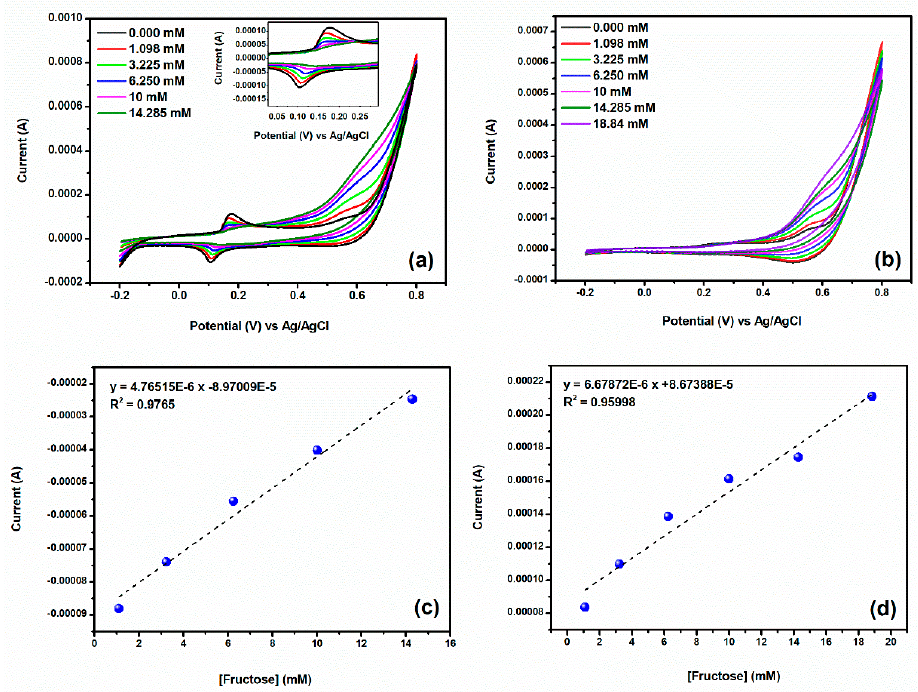
Figure 10. Effect of fructose concentration in 0.1 M NaOH solution at a scan rate of 25 mV s − 1 using ( a ) HPC-Co (1) modified electrode and ( b ) HPC-CoO (2) modified electrode. Calibration curves obtained ( c ) from the redox peak (I/II) in (1) and ( d ) from the redox peaks (III/IV) in (2). In the case of HPC-Co (1), the redox peak current of (I/II) is inversely proportional to fructose concentration. Therefore, this method can be used as indirect quantitative detection of fructose (Figure 10c). The redox peak current of (III/IV) is directly proportional to fructose concentration in the case of HPC-CoO (2), (Figure 10d). The lower detection limits are the same 0.5 mM for (1) and